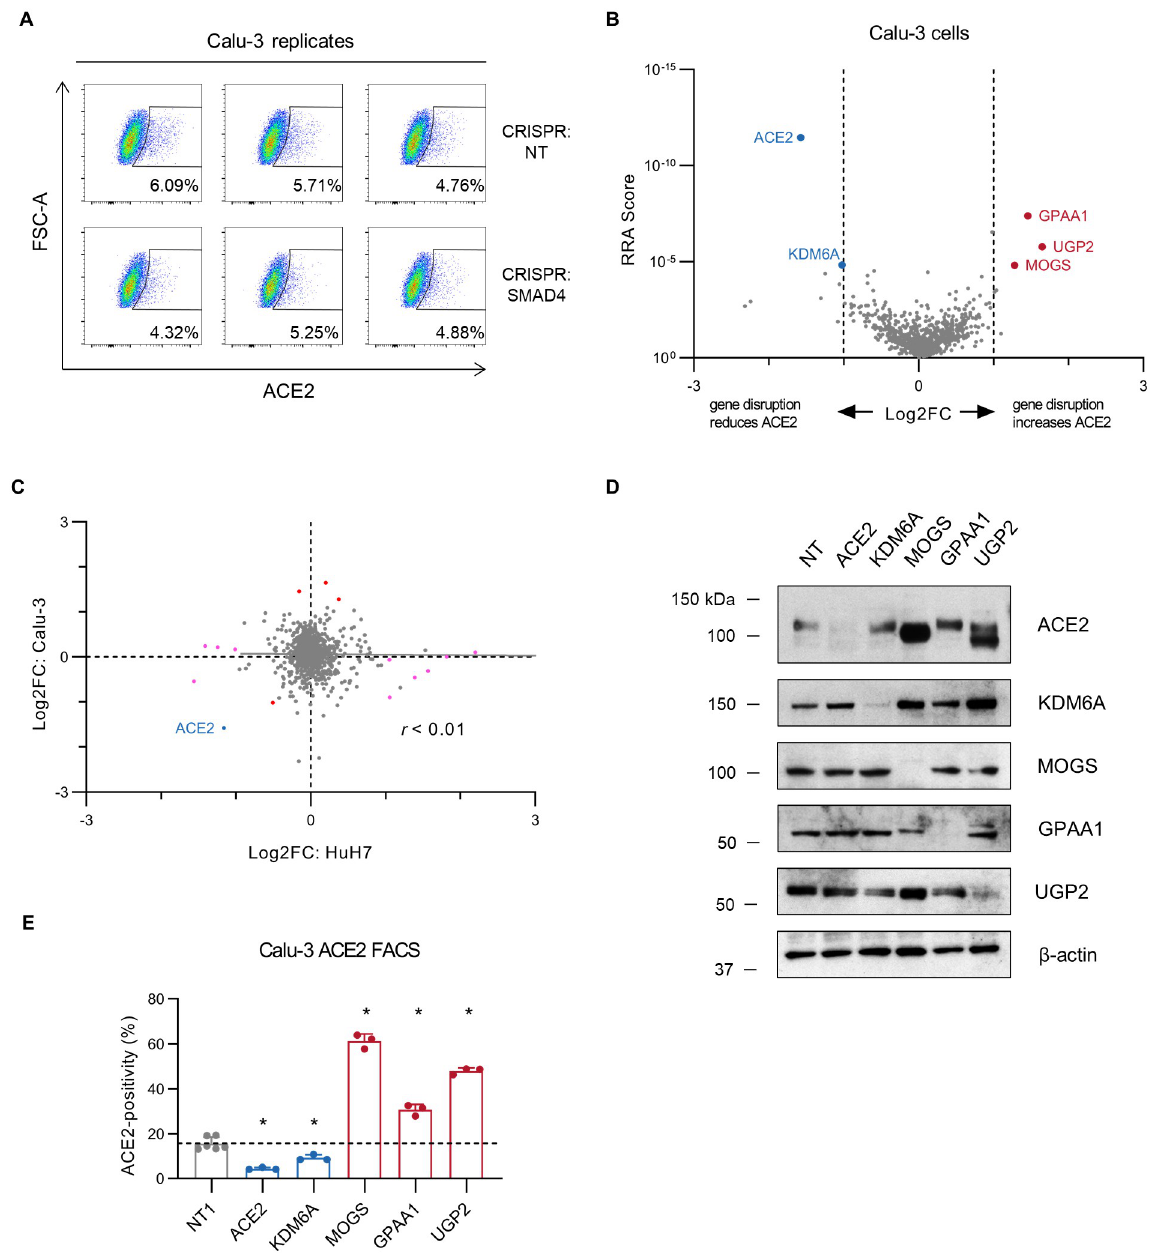
Fig 6. Interrogation of ACE2 modifiers in Calu-3 cells. (A) FACS plots of ACE2 surface staining in Calu-3 cells treated with control nontargeting (NT) or SMAD4 -targeting gRNA for each of 3 technical replicates. (B) Volcano plots of MAGeCK Robust Rank Aggregation scores and gene-level gRNA log 2 fold-change in ACE2 negative relative to ACE2 positive populations for each gene tested in the focused CRISPR library in Calu-3 cells. Genes with FDR < 0.05 and absolute log 2 fold-change > 1 are highlighted, with positive regulators in blue and negative regulators in red. (C) Comparison of log 2 fold-change in ACE2 negative relative to ACE2 positive populations in focused CRISPR screens of HuH7 (x-axis) and Calu-3 (y-axis). Only ACE2 , highlighted in blue, was identified in both screens with FDR < 0.05 and absolute log 2 fold-change > 1. Genes identified as significant in only the HuH7 or Calu-3 screens are highlighted in magenta and red, respectively. (D) Immunoblotting of lysates collected from Calu-3 cells targeted by CRISPR with a gRNA against the indicated gene or a nontargeting (NT) control sequence. (E) Percentage of cells with detectable surface ACE2 staining after CRISPR-mediated single gene disruption of the indicated target gene or a nontargeting control in Calu-3 cells. Candidate genes associated with positive or negative regulation of ACE2 in the CRISPR screen are highlighted in blue and red, respectively. ACE2-positive gates were defined on control unstained cells and the proportion of ACE2-positive cells for each population is displayed for each of 3–6 technical replicates. Error bars depict standard deviation. Asterisks indicate p < 0.05 by Student’s t-test. Source data and statistical analysis are provided in S9